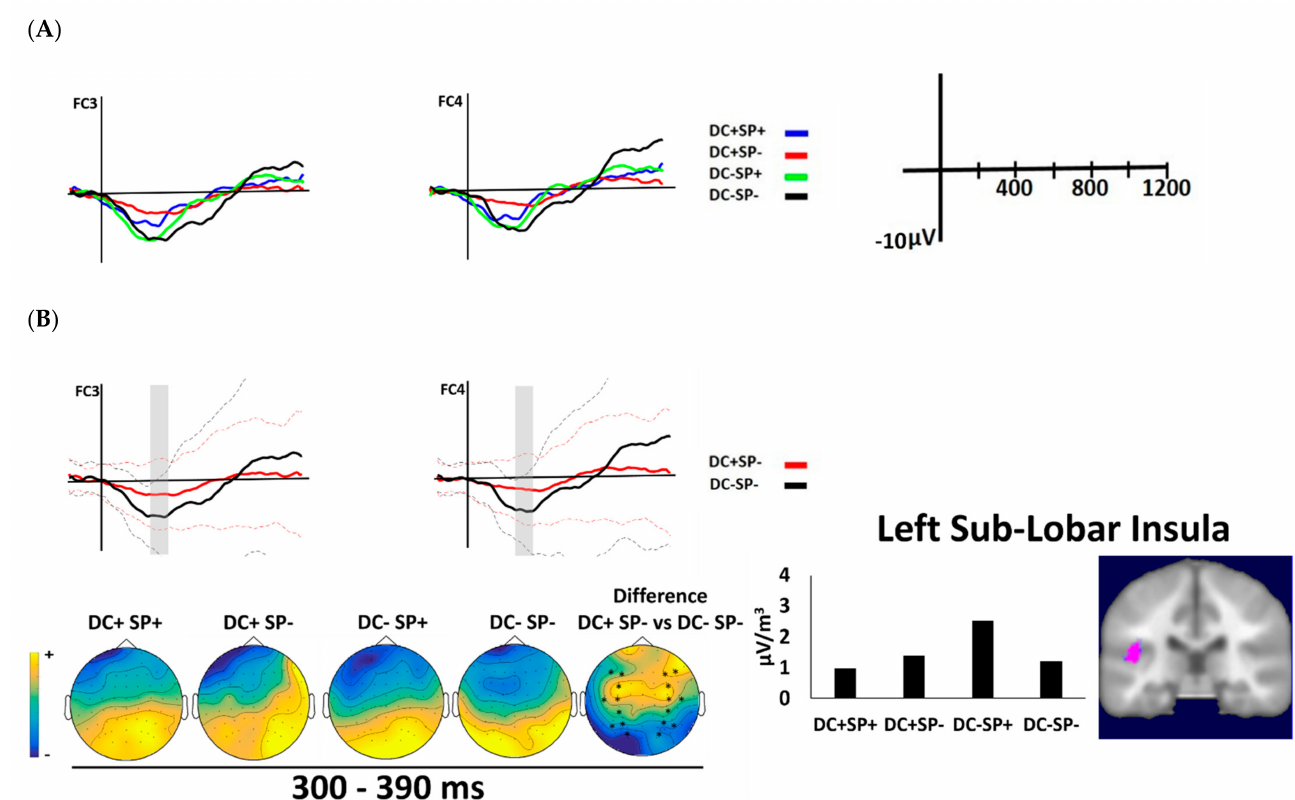
Figure 4. ( A ) Grand average waveforms for congruous duration (DC+) and incongruous duration (DC − ) and semantically predictable (SP+) and unpredictable (SP − ) sentences for the four experi- mental conditions at FC3 and FC4 as function of semantic task. ( B ) Grand average waveforms of N400 component for DC+ SP − and DC − SP − contrast conditions. The time windows with a contrast are indicated in gray. The dotted lines indicate the standard deviations. Left: spatial distributions resulting from the comparison between the conditions. The asterisks at the topographical maps show the used electrodes. Right: current density values for the contrast and their brain spatial localization for the duration contrast (L